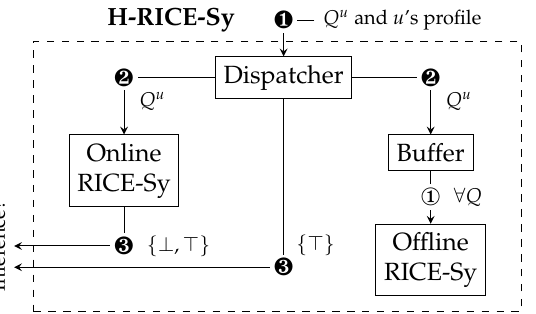
Figure 11. Workflow of the hybrid RICE-Sy (H-RICE-Sy). The arrows labels with a black or white backgrounds mean that the action is performed online or offline,